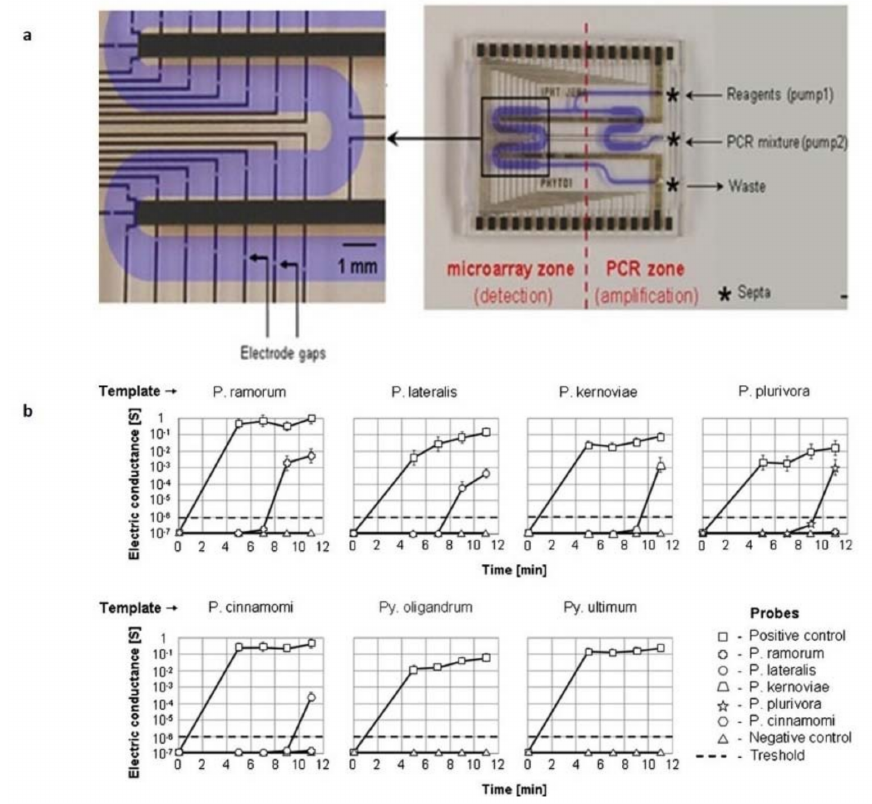
Figure 5. ( a ) A microfluidic chip allowing PCR and hybridization steps; ( b ) Electrical readout, demonstrating detection of five Phytophthora species (adapted from [87] with permission).